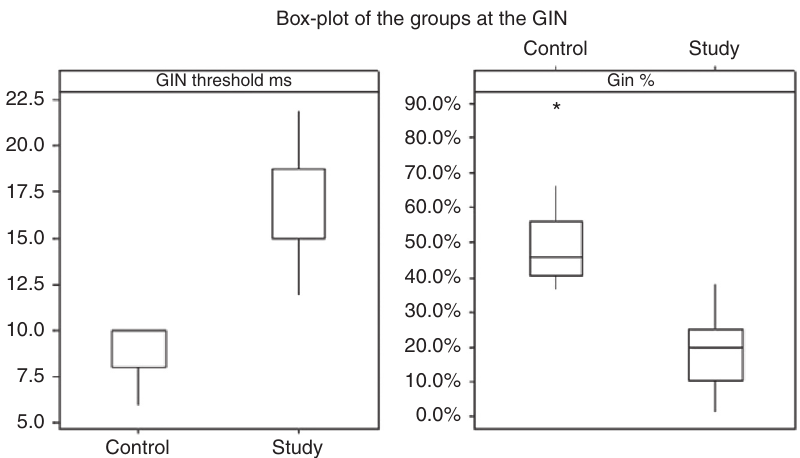
Control group and study group performance at the Gaps-in-Noise test.